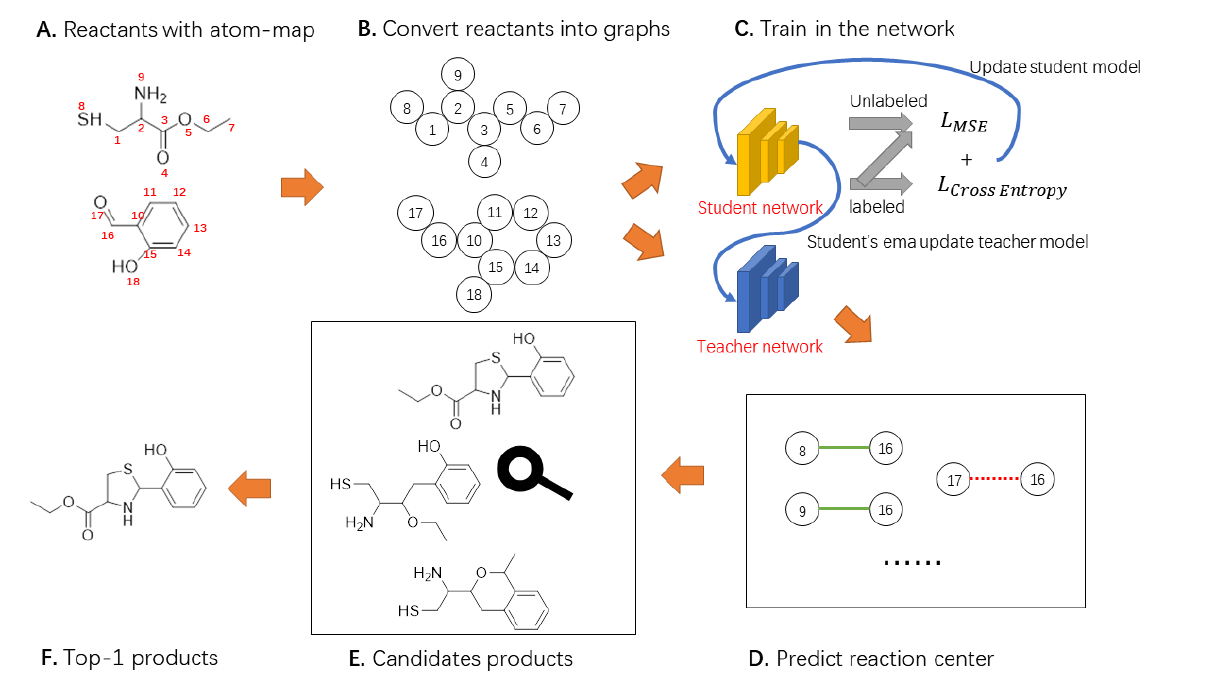
Figure 4. The general framework of our model. We describe the reactants as a graph. The student model learns reactant features to predict reaction centers. The teacher model uses the EMA of the student model to update parameters, then constructs better labels for the student to learn. Next, the candidate product set was constructed according to the reaction center. Finally, the score for each product is